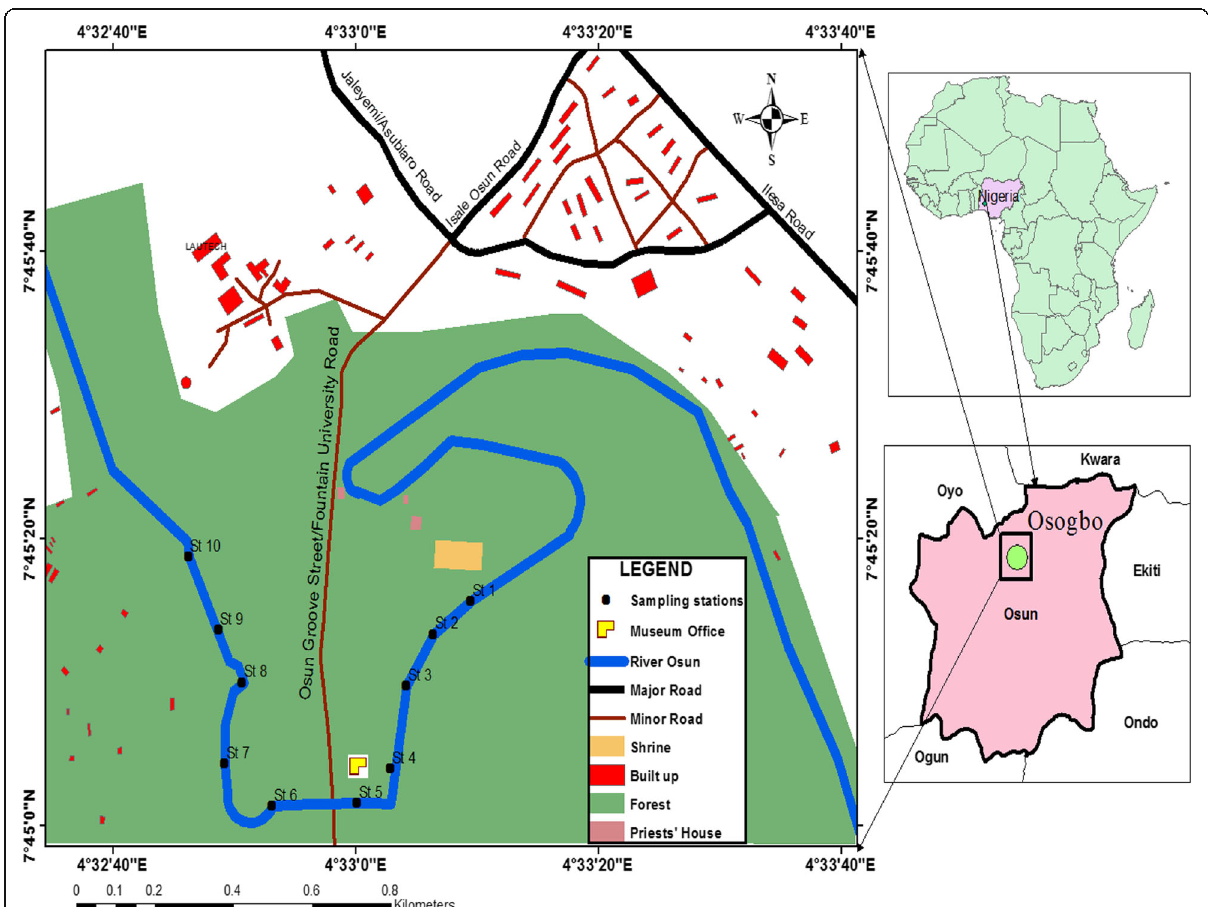
Fig. 1 Map of the study area within the protected section of Osun Grove, a World Heritage Site in Osogbo,